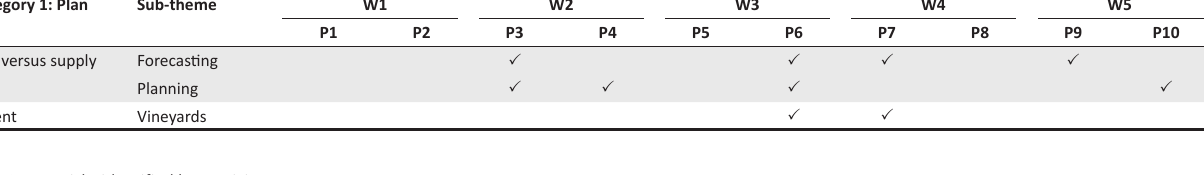
TABLE 3 : Source risks identified by participants. Risk Category 2: Source